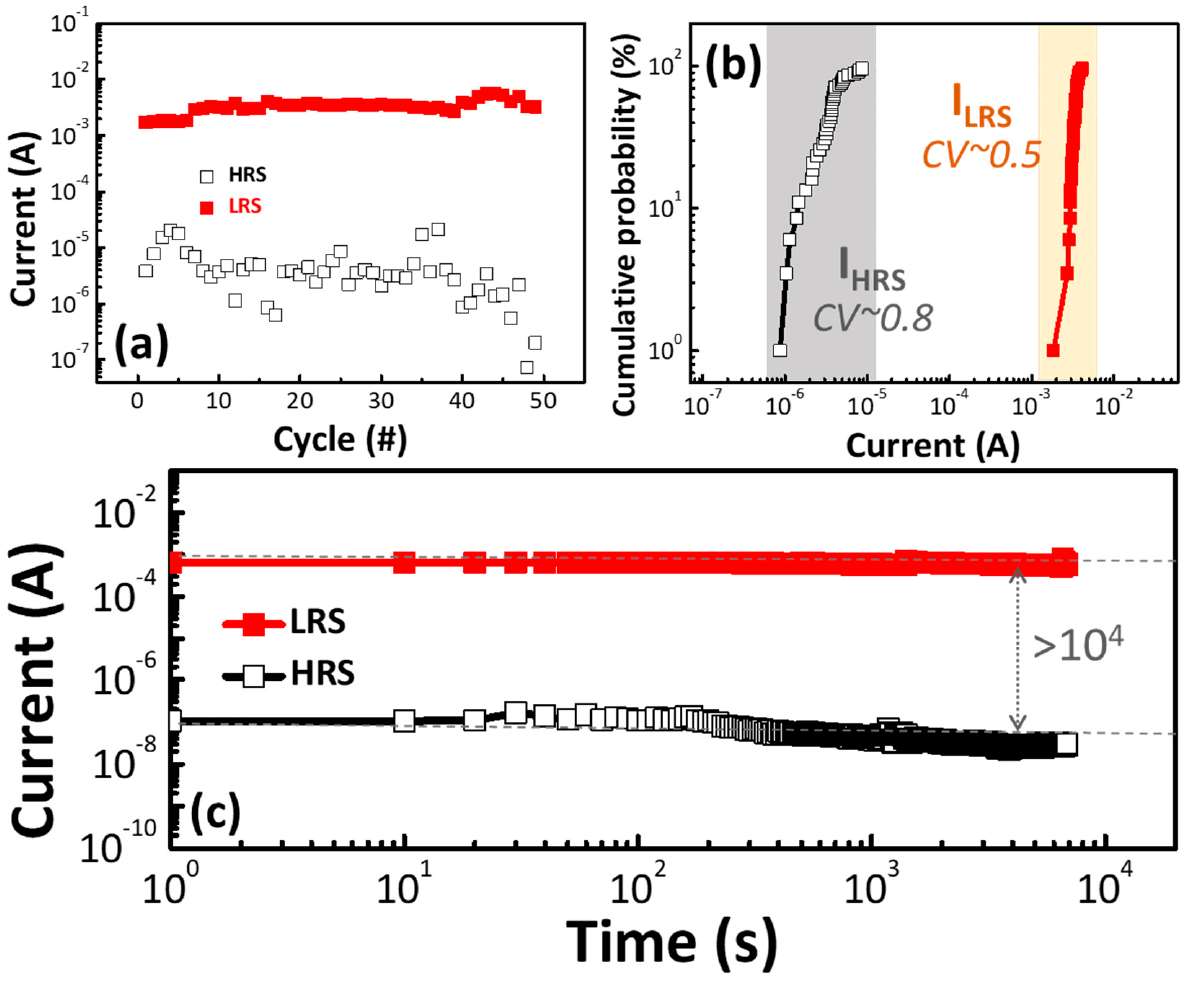
Figure 3. ( a ) Cycling I–V measurements of the C1 memory device. ( b ) The cumulative probability of the HRS and LRS current values for the C1 memory device under a read bias of 0.1 V. ( c ) Retention property of the C1 memory device at room temperature.